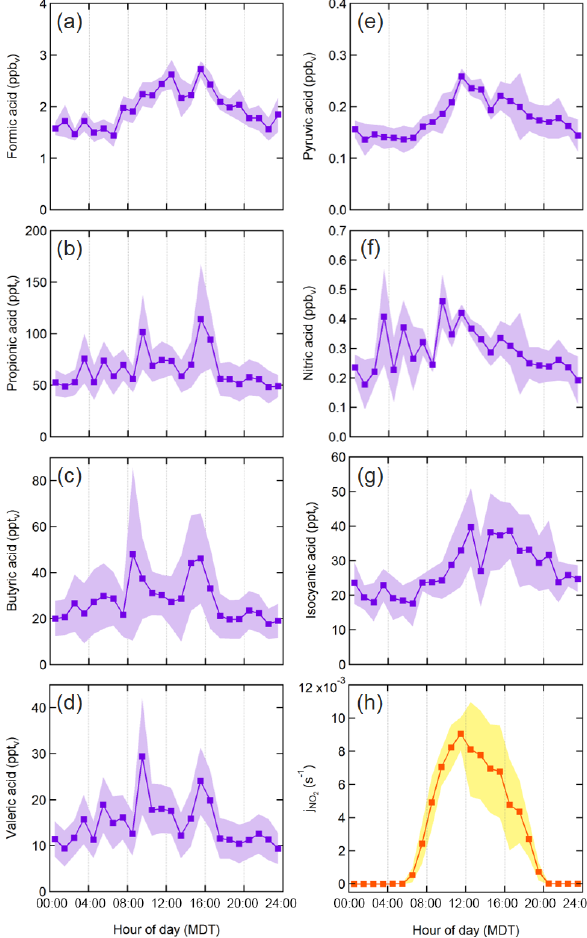
Figure 2. (a–g) Diel profiles for all detected gas-phase acids at 100m. (h) Diel profile for j NO measured at the site. Data are 2 binned by hour. Data points are means of hourly bins. Shaded area represents ± one standard deviation of binned